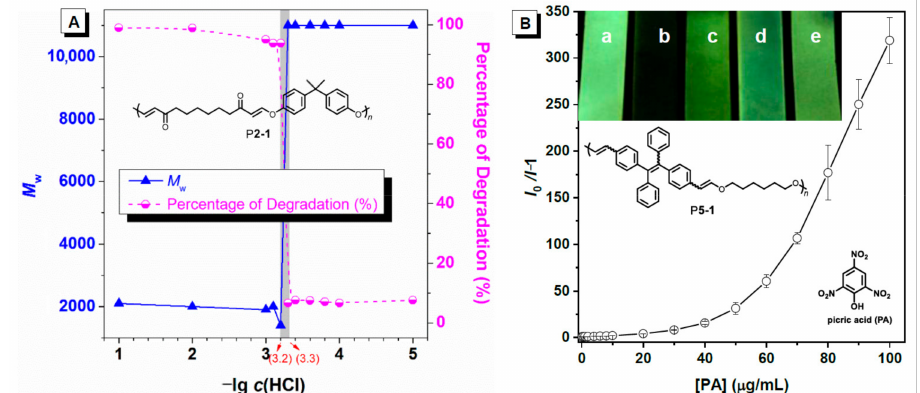
Figure 1. ( A ) The plots of the weight-average molecular weight ( M w , solid blue line) and percentage of degradation (dash pink line) of P 2-1 versus different concentrations of hydrochloric acid. (Copyright 2017, Wiley) ( B ) Stern–Volmer plots of I 0 / I − 1 of P 5-1 in tetrahydrofuran /water mixtures ( f w : 80%) and P 5-1 in a THF versus PA concentration, where I = peak intensity and I 0 = peak intensity at [PA] = 0 µ g/mL. Inset: the chemical structure of PA and fluorescence images of P 5-1 containing strips (a, b, c, d, and e represent strips after dipping into 0, 5000, 500, 50, and 5 µ g/mL aqueous solutions of PA) upon irradiation with a hand-held lamp (365